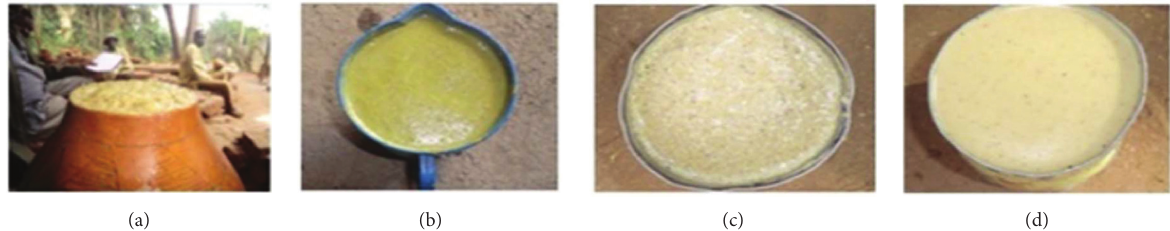
Figure 1: Cheka. (a) Fasha or chaqa and (b) hiba or parshota produced in low-land areas of Dirashe. (c) Hiba or parshota produced in high land areas of Dirashe and (d) menna (Photosource: Worku et al., 2015 [5]).